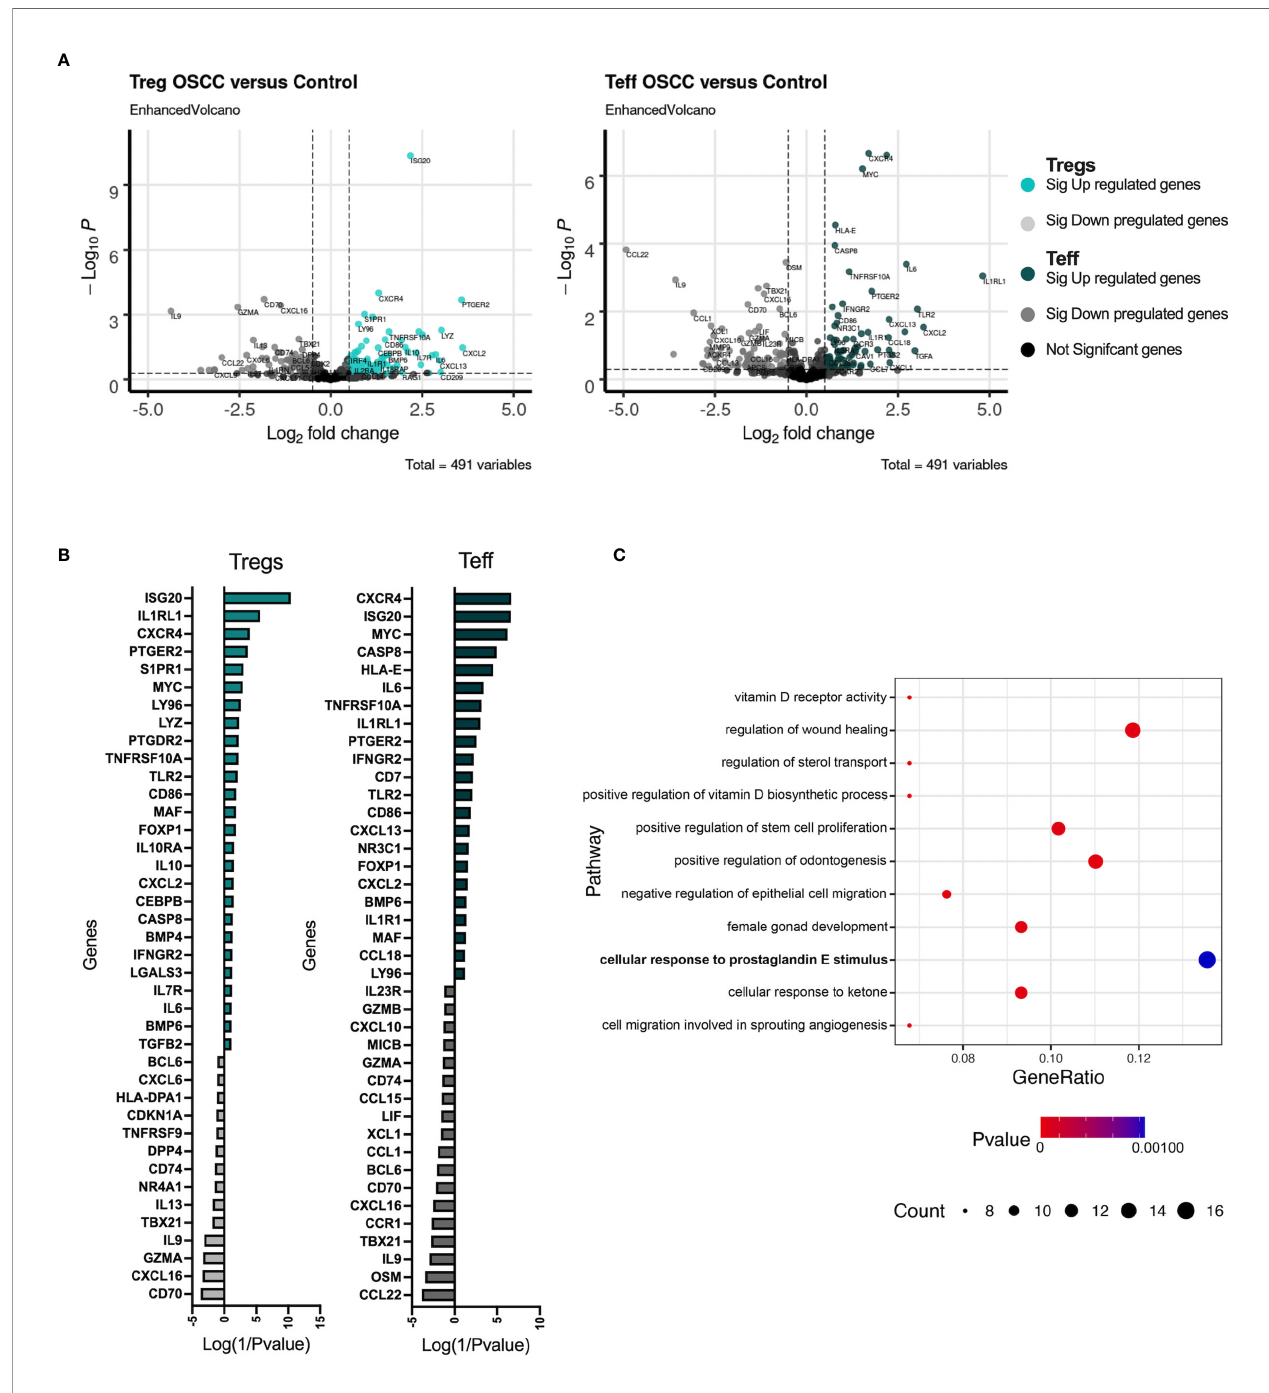
FIGURE 5 | Transcriptomic analysis of Tregs and Teff after co-culture with control or OSCC secretome revealed pathways associated with the VitD and PGE2 signaling. (A) Volcano plots showing RNA-seq data obtained from 3 paired Tregs and Teff after co-culture with control or OSCC secretome. Vertical dotted lines indicate 1.5-fold change threshold and horizontal dotted line indicate P value 0.05. Colored dots show signi fi cant up regulated genes, whereas grey dots show signi fi cant down regulated genes in Th subsets when comparing cells co-cultured with OSCC secretome versus control secretomes. (B) Heatmap showing upregulated (colored with positive values) and downregulated (grey with negative values) genes in Tregs and Teff after co-culture with control or OSCC secretome. Log(1/Pvalue) was used to normalize the p values obtained when comparing each gene between control and OSCC secretome in Treg or Teff. (C) A pathway enrichment analysis was performed using the Gene Ontology Consortium database (data-version Released 2021-02-01) including biological processes. Cytoscape v.3.8.2 with the ClueGO plugin v.2.5.7 was used with a (p<0.01) and a kappa statistics score = 0.4 to calculate the relationships between the terms based on the similarity of their associated genes. Circles represent gene counts found in each pathway and p value is the probability of seeing at least x number of genes out of the total n genes in the list annotated to a particular GO